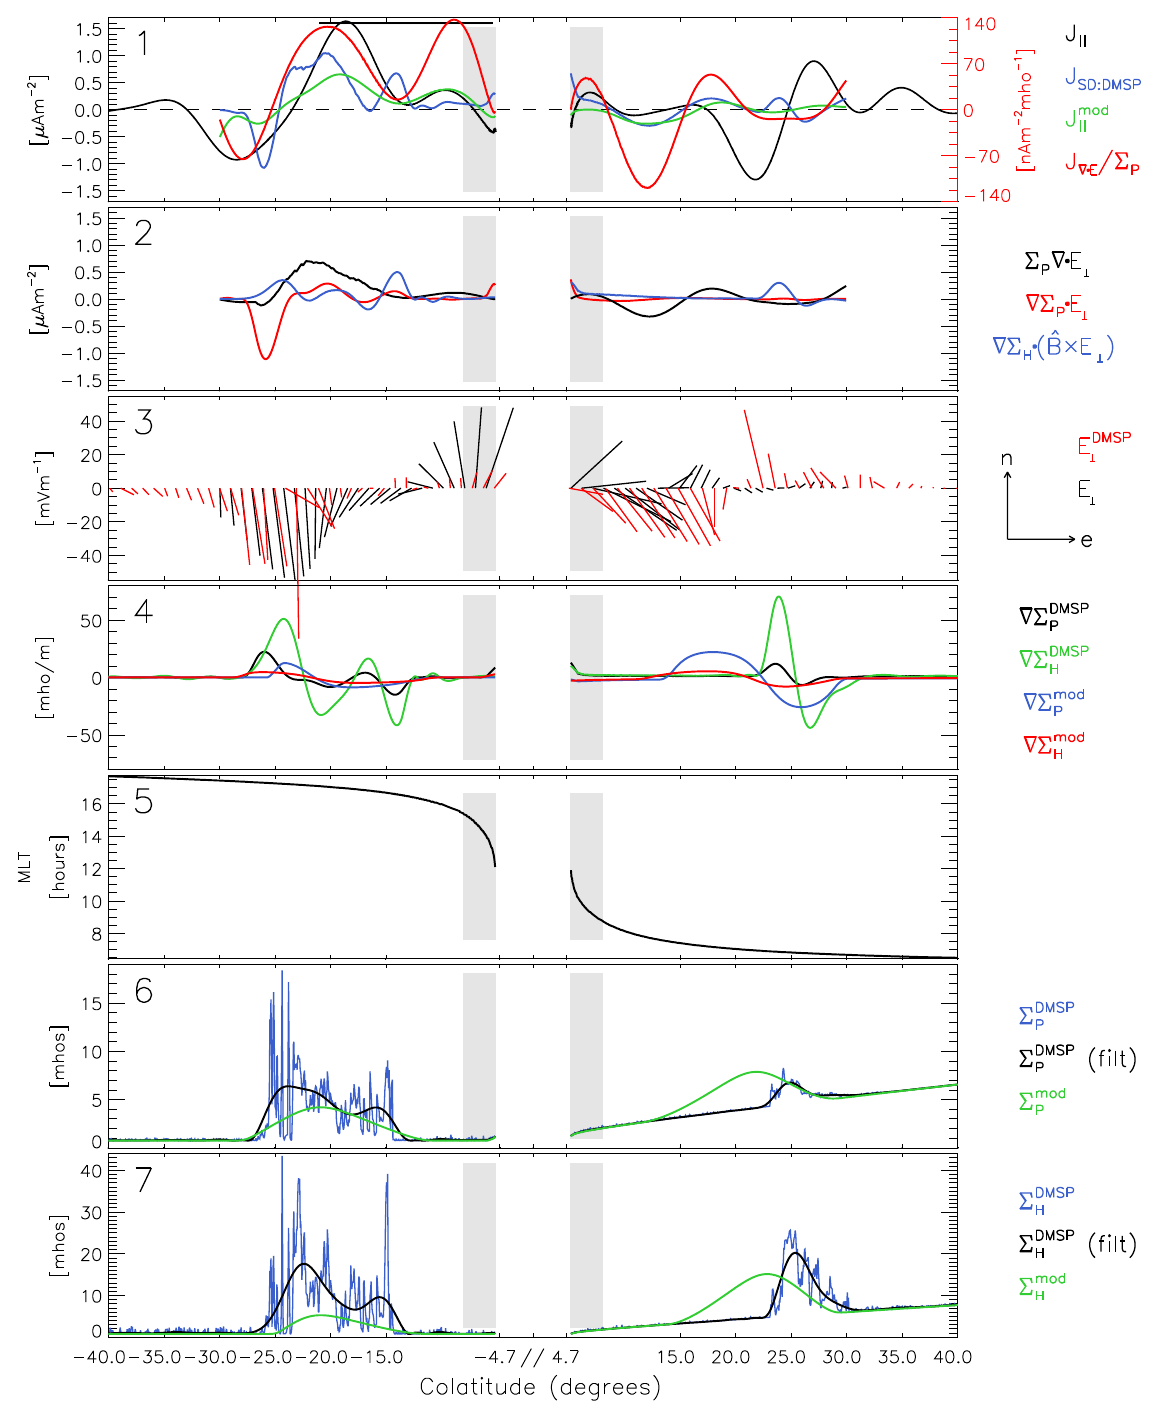
Fig. 18. Iridium, DMSP F13, and radar data for 3 October, 2002. Panel 1: Birkeland currents estimated from various sources (see text), panel 2: Birkeland current terms from Eq. (3) using DMSP F13 derived conductance, panel 3: Electric field from the radars and DMSP drift meter data, panel 4: DMSP F13 and model derived conductance gradients, panel 5: DMSP satellite MLT coordinate, panel 6: Pedersen conductance derived from the DMSP F13 data and the conductance model, panel 7: Hall conductance derived from the DMSP F13 data and the conductance